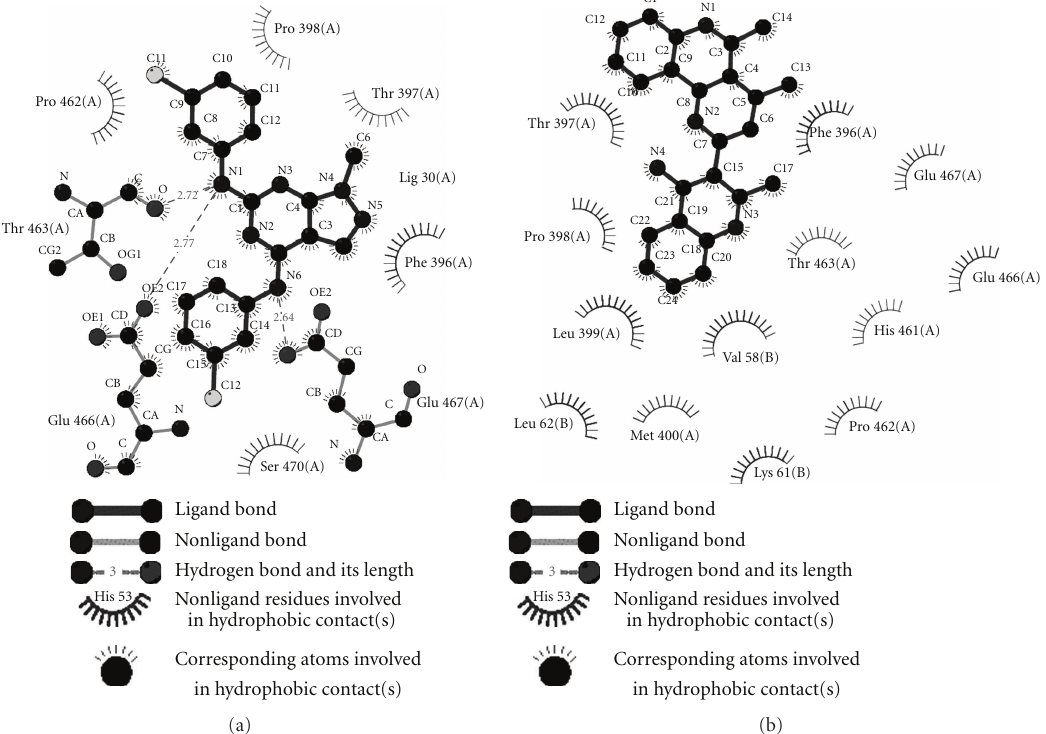
Figure 6: Compound 30 (a) of Cluster 3 in hydrogen bonding interaction with Glu466, Glu467, Thr463, Pro398, and Phe396 of the Z site is in hydrophobic contact with the inhibitor. Compound 35 (b) is in hydrophobic interaction with all the Z site residues, and there are other amino acids in non-boding interactions making it a high-a ffi nity